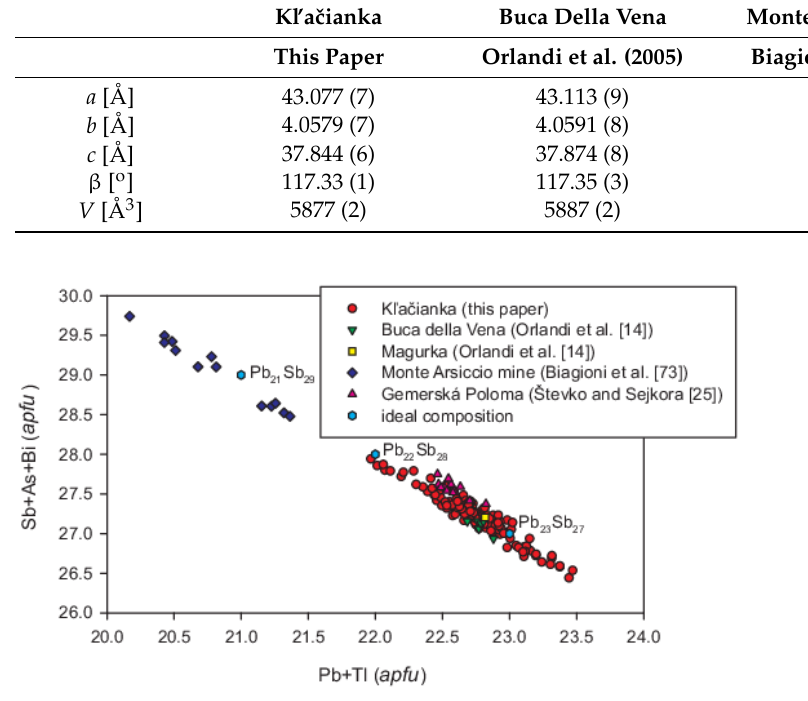
Figure 11. Chemical composition of rouxelite in the graph Pb + Tl vs. Sb + As + Bi (apfu ).